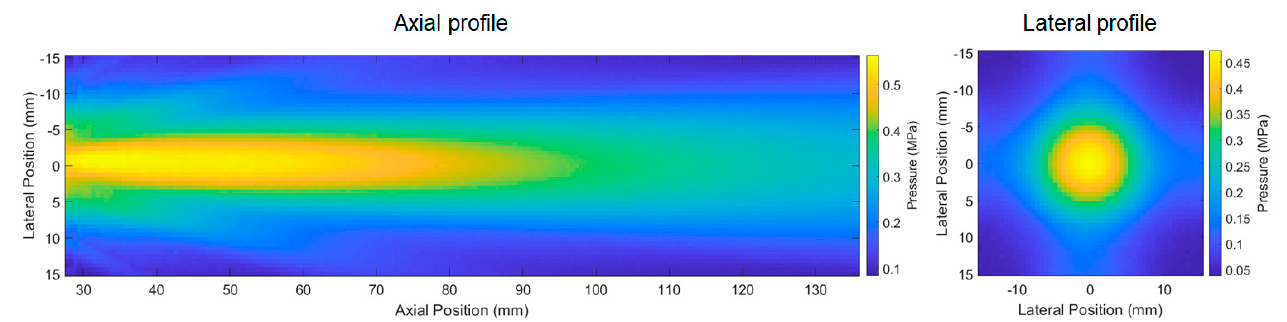
Figure 6. Beam mapping by using the type A transducer, 590 kHz, 10 − cycle burst excitation. The lateral profile was mapped at the plane 72 mm (29 λ ) away from the transducer surface. lateral profile was mapped at the plane 72 mm (29 λ ) away from the transducer